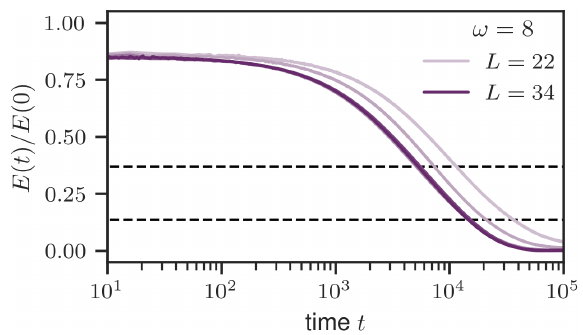
FIG. 5. The normalized energy versus time. Light to dark (right to left) curves correspond to L ∈ [22, 34] in steps of 2. All data are for ω = 8, the largest frequency we consider in Fig. 3. The dashed horizontal lines are at the thresholds e − 1 and e − 2 , which are used to extract the thermalization rate (cid:9) , as described in the main